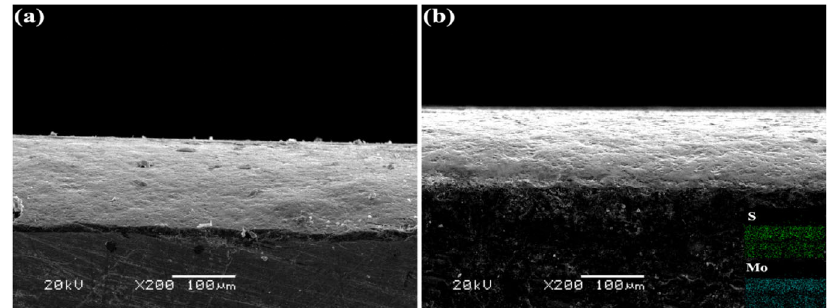
Fig. 5 SEM images of the cross sections of the (a) pristine and (b) 3 wt% MoS 2 -MWCNT-1 filled polyurethane composite